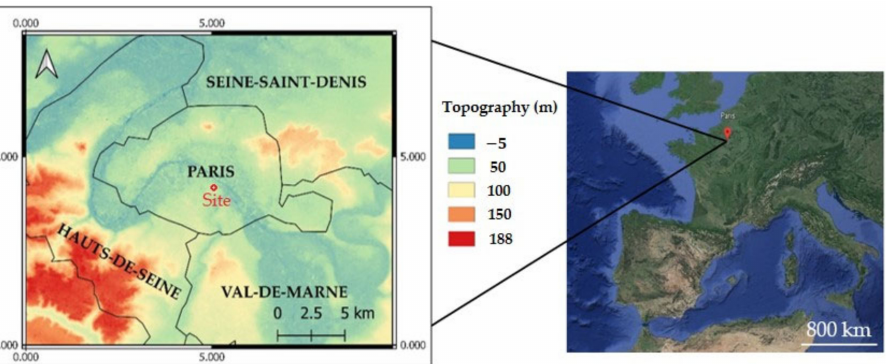
Figure 1. Situation of the study area (a red point) in the city of Paris (France), with the coordinate system of RGF93, Lambert 93. Topographic data source is from the site urs.earthdata.nasa.gov accessed on 24 February